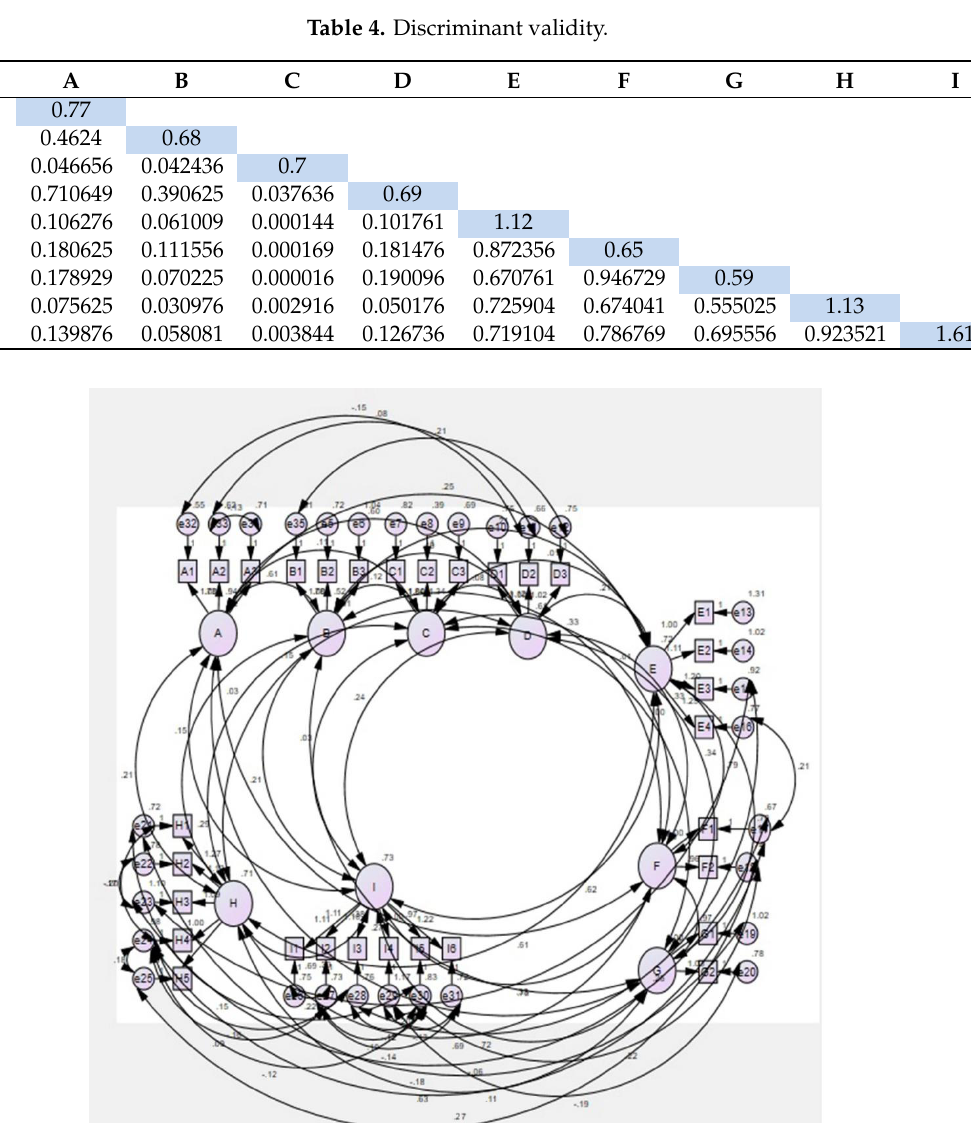
Figure 4. Results of the confirmatory factor analysis (see Table 1 for the codes).